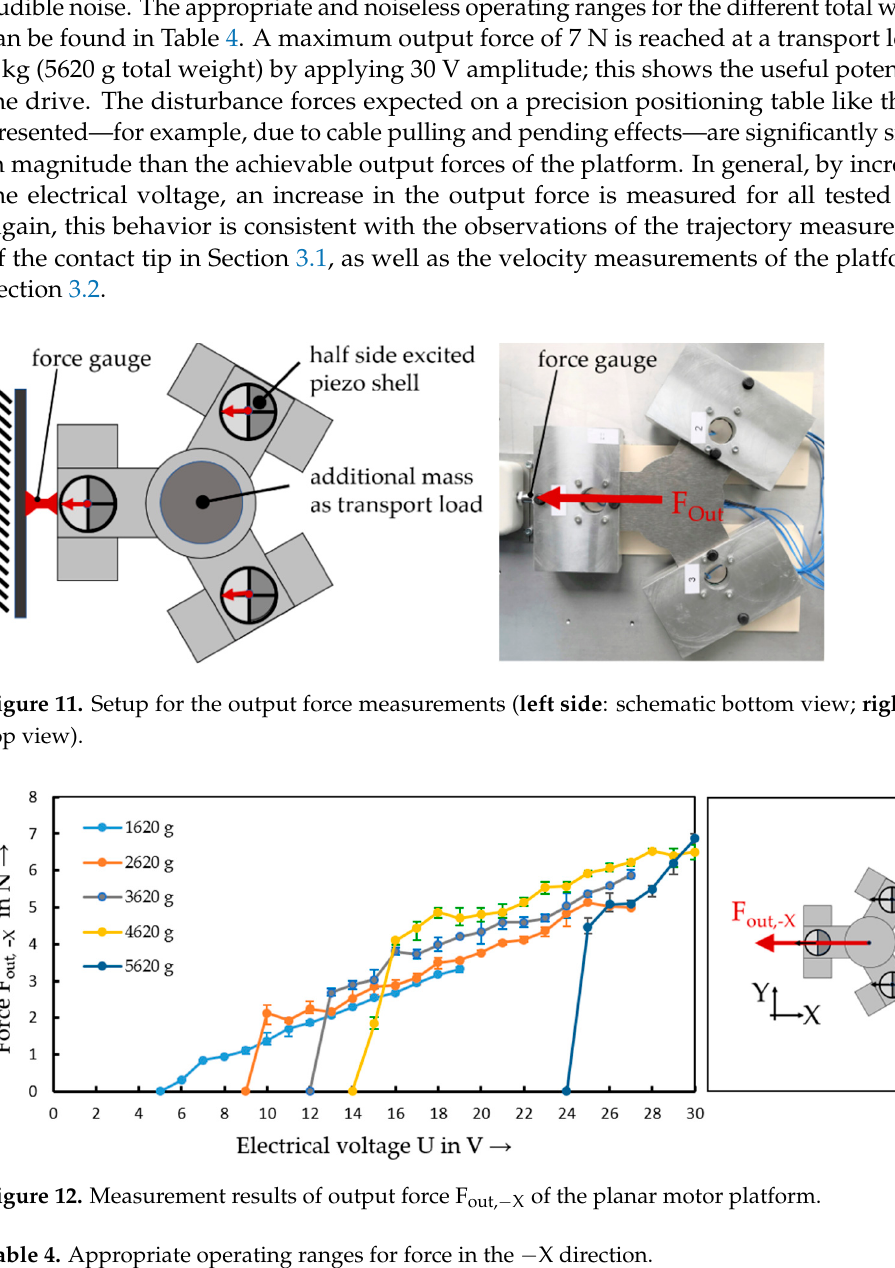
Table 3. Appropriate operating ranges for velocity in the +Y direction.